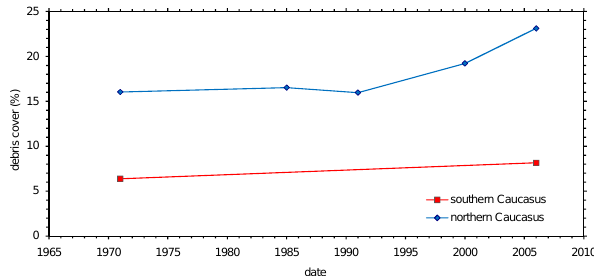
Fig. 8. Relative debris covered area on the glaciers of the two in- vestigated basins in the Caucasus for a time span of 35